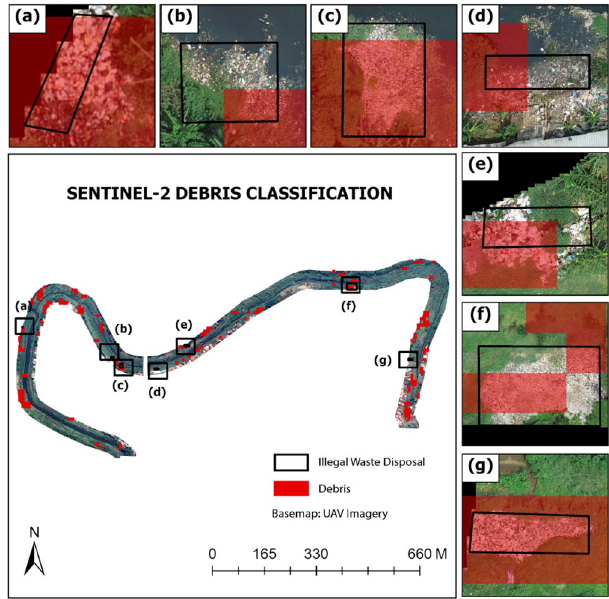
Figure 4. Sentinel 2A debris classification using NDVI, NDBI, PI Sentinel 2 + 12 Band Sentinel